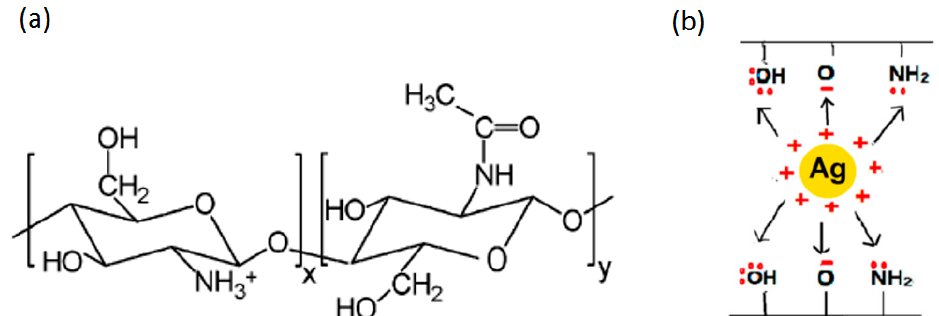
Figure 7. ( a ) The chitosan chemical structure after treatment with acetic acid; and ( b ) AgNPs interaction with negatively charged groups (NH 2 , O and OH) of chitosan [33].